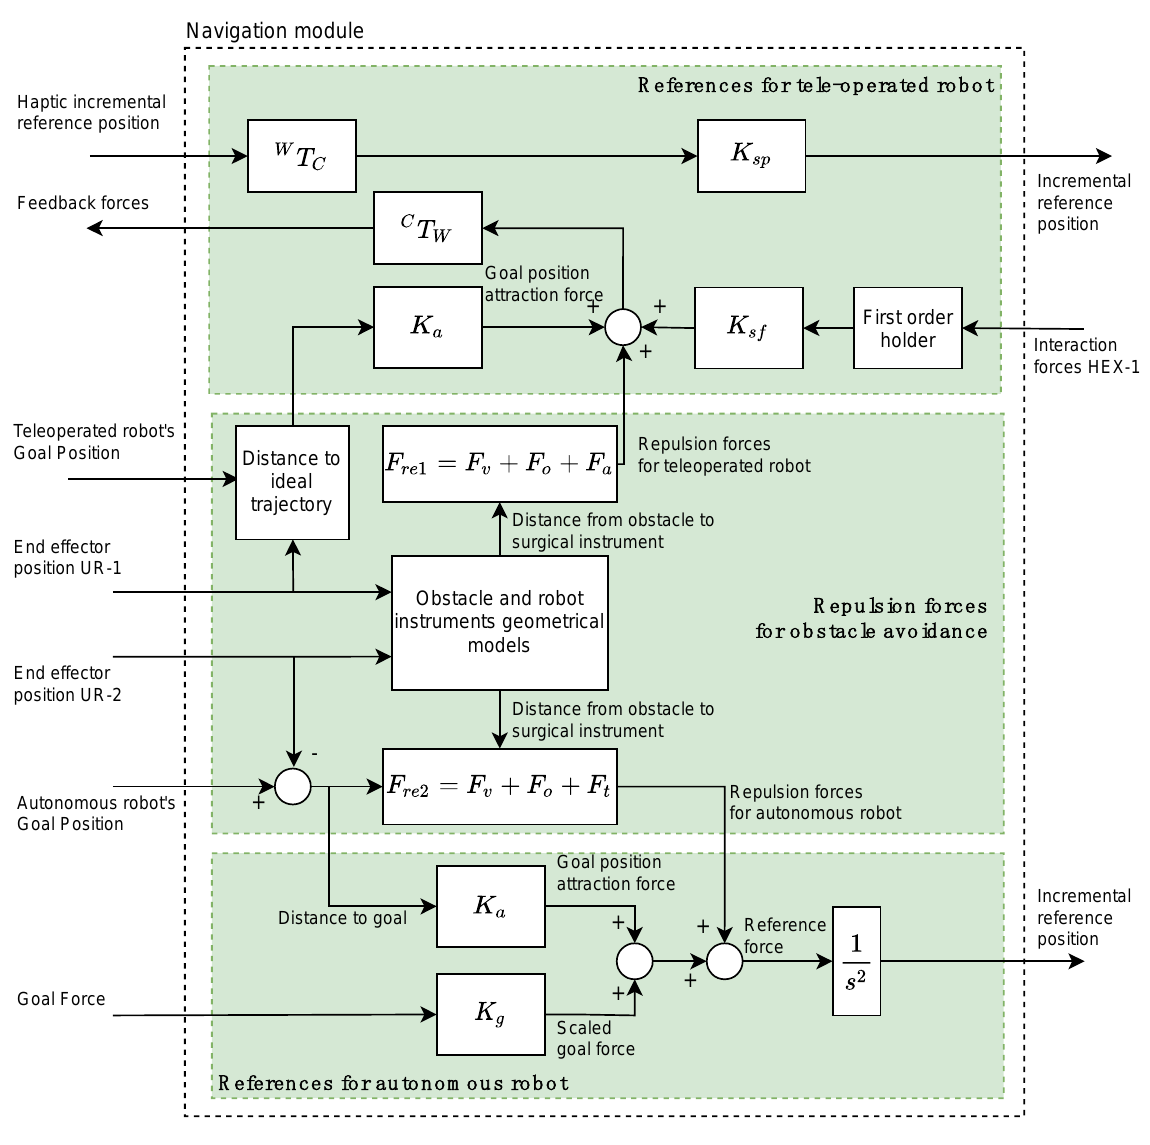
Figure 3. Navigation module and subsystems.